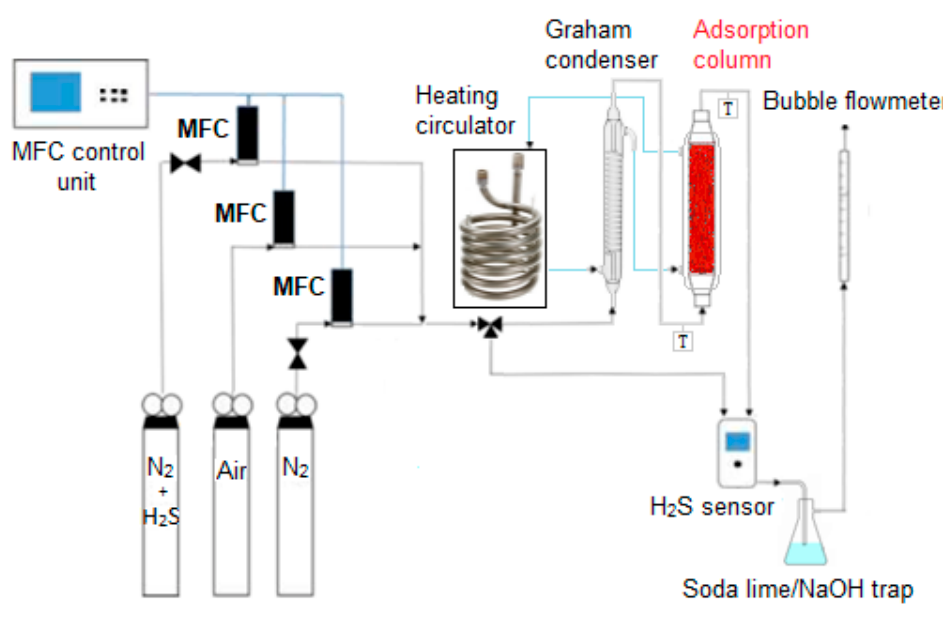
Figure 2. Schematic representation of the adsorption plant.